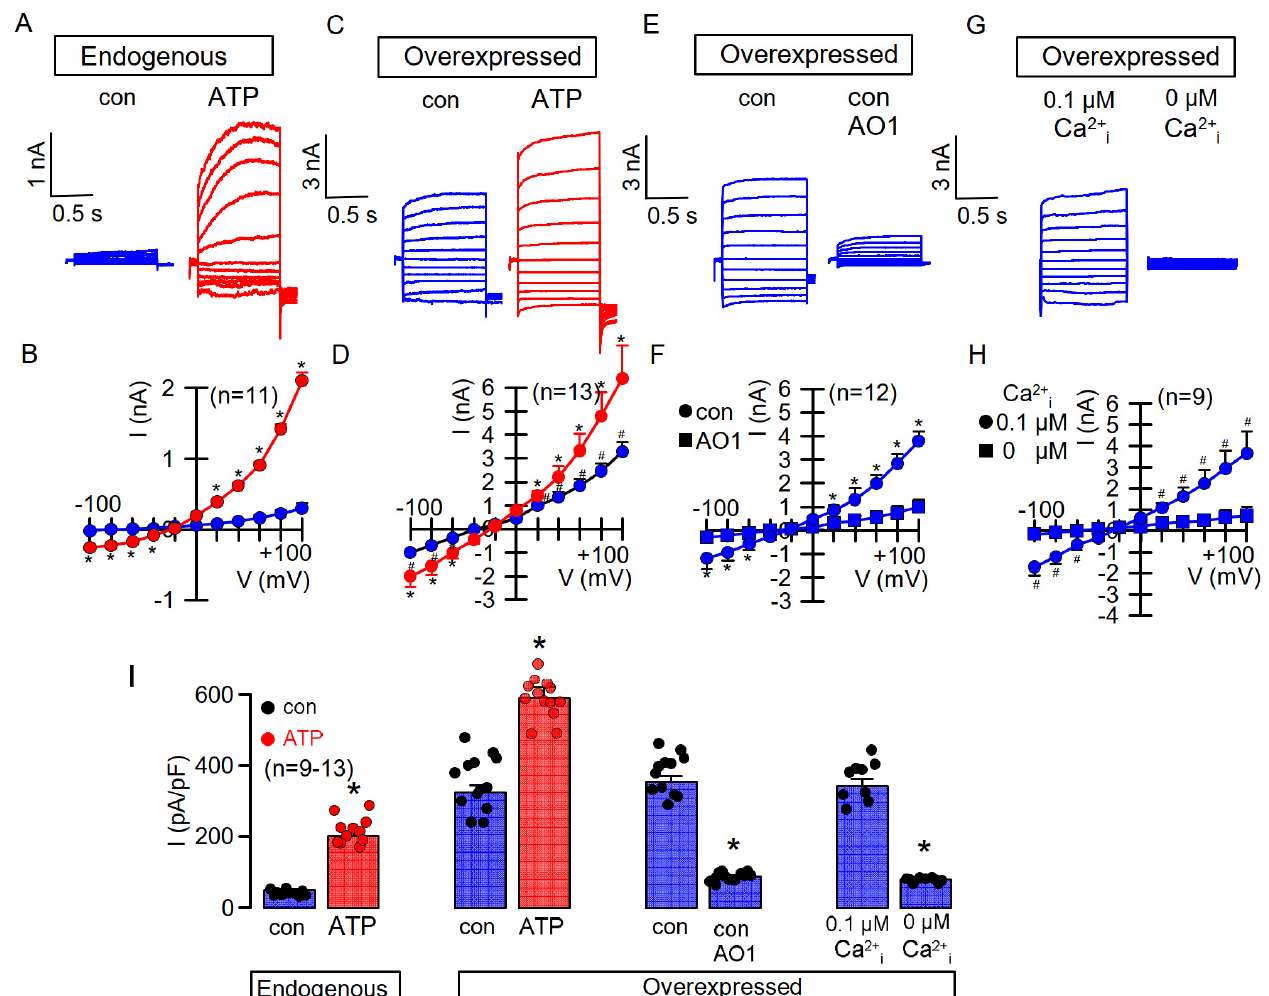
Figure 1. Overexpressed TMEM16A is spontaneously active due to enhanced Ca 2+ sensitivity. TMEM16A whole cell currents were activated by 100 µ M ATP in CFBE airway epithelial cells expressing TMEM16A endogenously ( A , B ) and in HEK293 cells overexpressing TMEM16A ( C , D ). A , B ) TMEM16A is closed under control conditions ([Ca 2+ ] i = 0.1 µ M) and is opened by ATP-induced increase in [Ca 2+ ] i .( C,D ) Whole cell currents were detected in TMEM16A-overexpressing cells under control conditions, with additional activation by ATP. ( E , F ) Whole cell currents detected under basal conditions were inhibited by the TMEM16A-blocker CaCCinhAO1 (AO1, 20 µ M). ( G , H ) Whole cell currents detected under control conditions ([Ca 2+ ] i = 0.1 µ M) were not detected in the absence of Ca 2+ in the pipette filling solution. ( I ) Summary of the current densities. Mean ± SEM (n = number of experiments). * Significant activation by ATP and inhibition by AO1, respectively ( p < 0.05; paired t -test). # Significant difference when compared to endogenous currents or in presence of 0 µ M [Ca 2+ ] i , respectively ( p < 0.05; unpaired t-test).